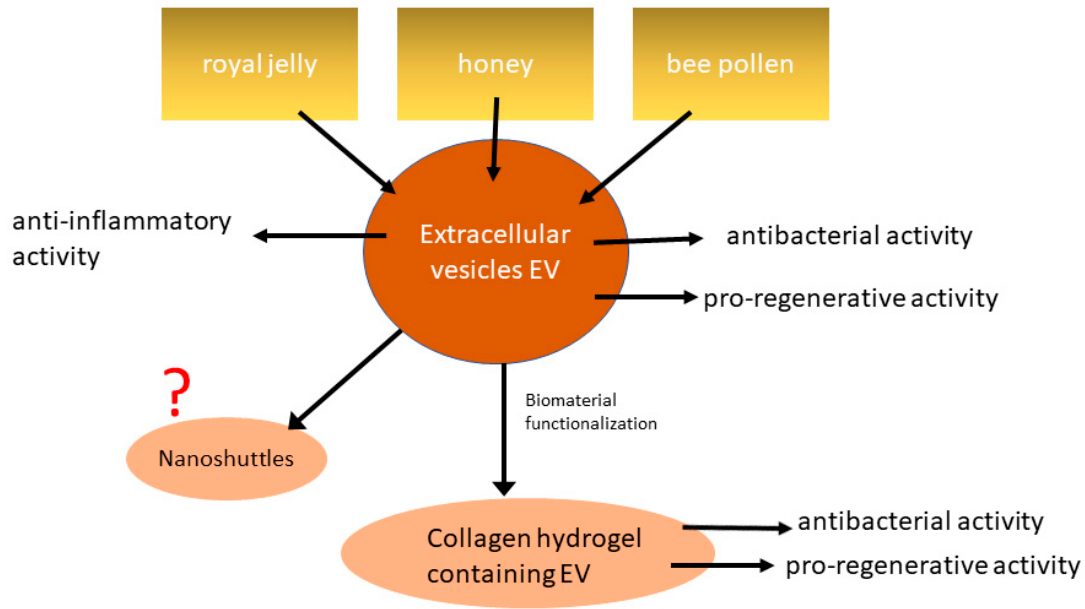
Figure 3. EVs have been identified in royal jelly, honey and bee pollen. Extracellular vesicles derived from bee products have antibacterial, pro-regenerative and anti-inflammatory activity that might be used in various medical applications.